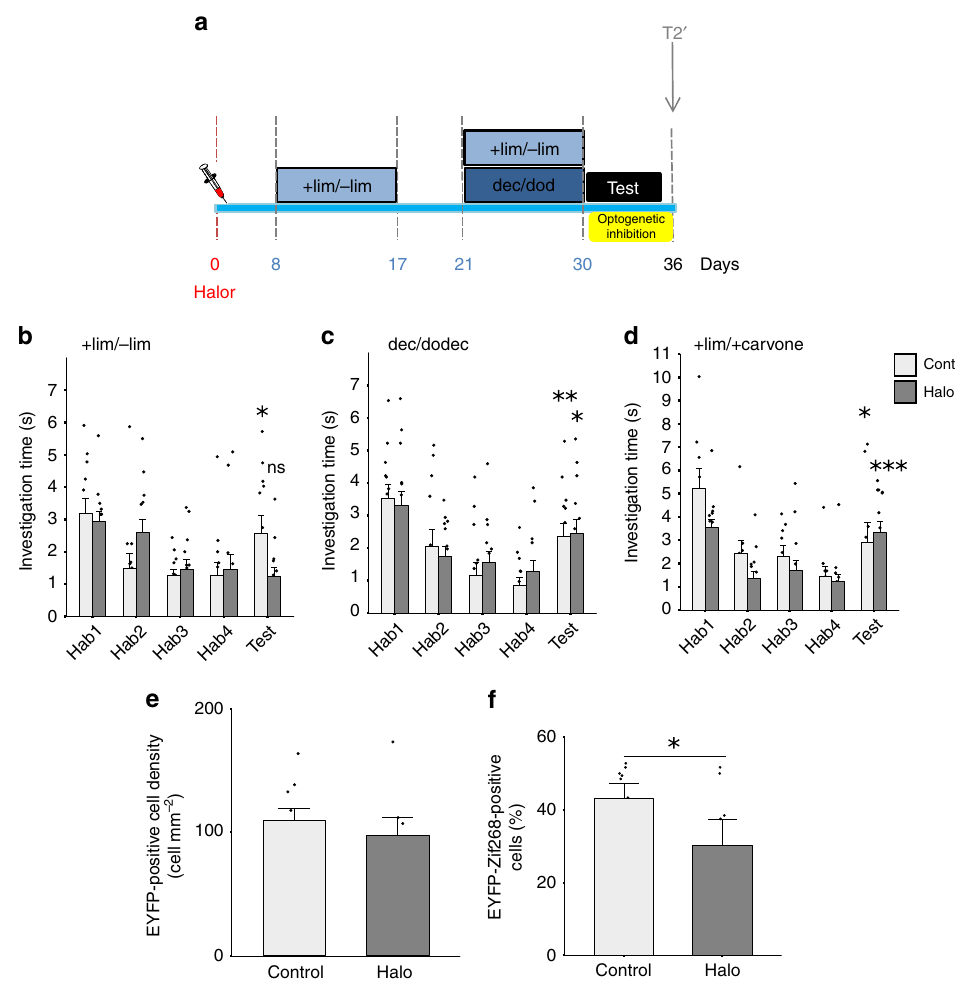
Fig. 4 Optogenetic inhibition revealed that distinct adult-born neuron cohorts underlined distinct memories. a Experimental design. Adult-born neurons aged 8 days at the beginning of the fi rst enrichment were transduced with a lentivirus expressing halorhodopsin (Halo) or with an empty virus (Cont). Light stimulation was performed during the test trial of the habituation/dishabituation task. b – d Behavioral results. b The learned discrimination of + lim/ − lim is abolished by light stimulation in the Halo group ( n = 13), but not in the Control group ( n = 12). c Discrimination between dec/dodec is not altered by light stimulation (Cont n = 13; Halo n = 14). d Discrimination between a dissimilar odorant pair + lim/ + carvone is not altered by light-triggered inhibition of adult-born neurons (Cont n = 9; Halo n = 14). t -tests * p < 0.05, ** p < 0.01, *** p < 0.001 (for difference between Hab4 and Test in b – d ). e The density of EYFP-positive transduced cells in the OB is similar between Control ( n = 9) and Halo ( n = 7) animals. f Percentage of EYFP/Zif268-positive cells after light-triggered inhibition is decreased in Halo ( n = 7) compared to Control ( n = 8). t -test * p < 0.05 (for difference between Halo and Control groups in f ). Data are represented as data points and mean ± sem. Source data are provided as a Source Data fi